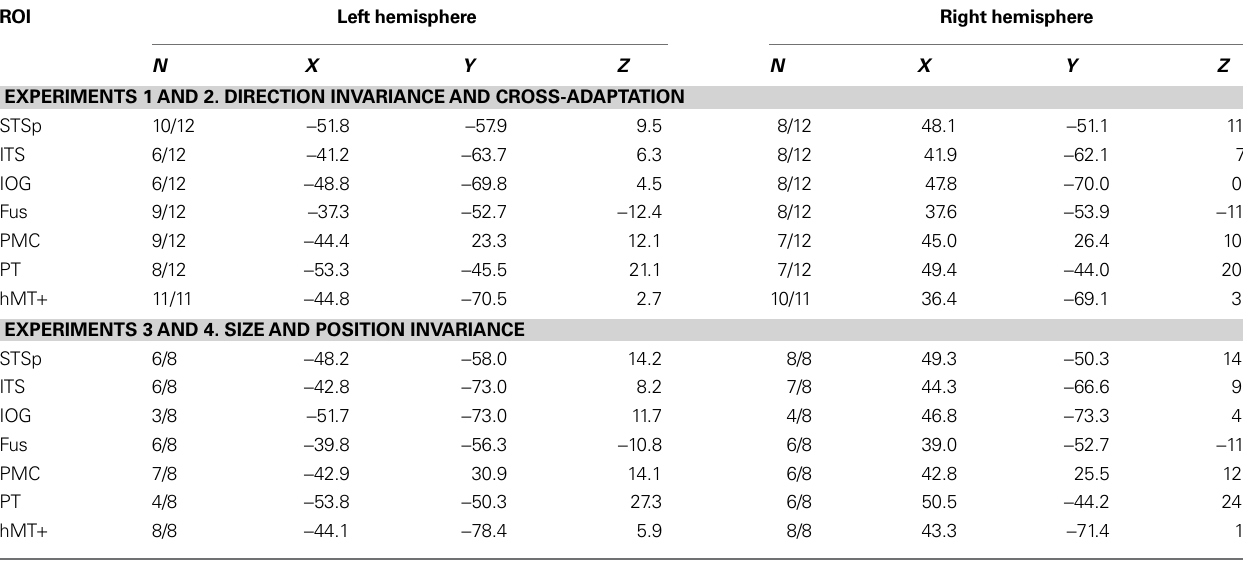
Table 1 | Mean Talairach coordinates for the ROIs isolated using the independent localizers on each subject. ROI Left hemisphere Right hemisphere N X Y Z N X Y Z EXPERIMENTS 1 AND 2. DIRECTION INVARIANCE AND CROSS-ADAPTATION